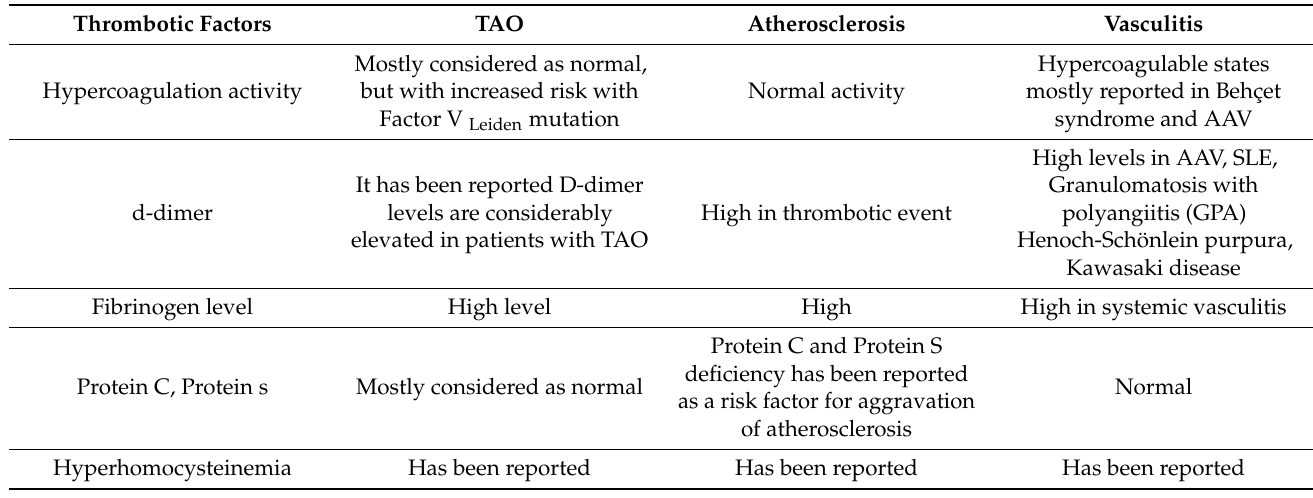
Table 5. Summary of the main findings on thrombotic factors.